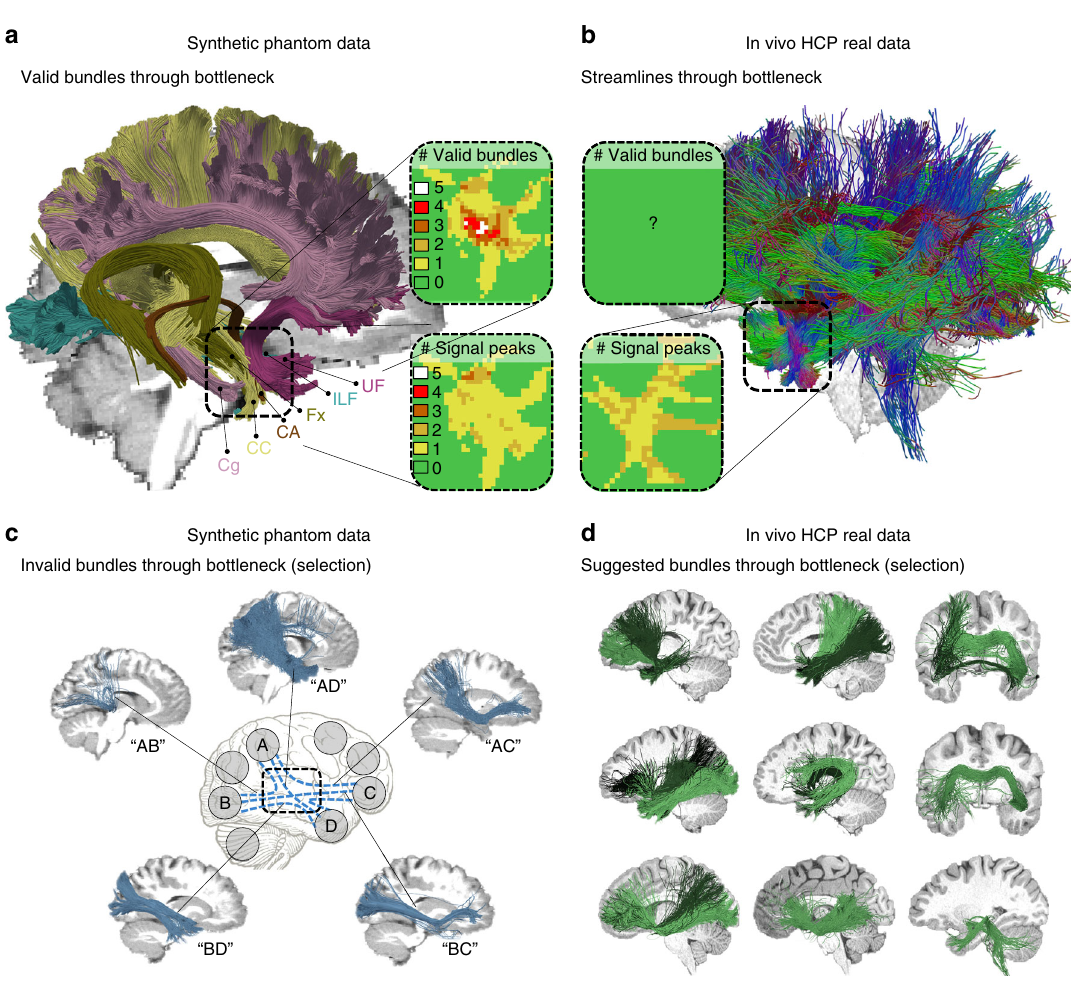
Fig. 8 Bottlenecks and the fundamental ill-posed nature of tractography. a Visualization of six ground truth bundles converging into a nearly parallel funnel in the bottleneck region of the left temporal lobe (indicated by square region). The bundles per voxel (box “ # Valid bundles ” ) clearly outnumber the peak directions in the diffusion signal (box “ # Signal peaks ” ). b Visualization of streamlines from a HCP in vivo tractogram passing through the same region. c Exemplary IBs that have been identi fi ed by more than 50% of the submissions, showing that tractography cannot differentiate between the high amount of plausible combinatorial possibilities connecting different endpoint regions (see Supplementary Movie 1). d Automatically QuickBundle-clustered streamlines from the in vivo tractogram going through the temporal ROI. The clustered bundles are illustrated in different shades of green. These clusters represent a mixture of true-positive and false-positive bundles going through that bottleneck area of the HCP data set (see Supplementary Movie